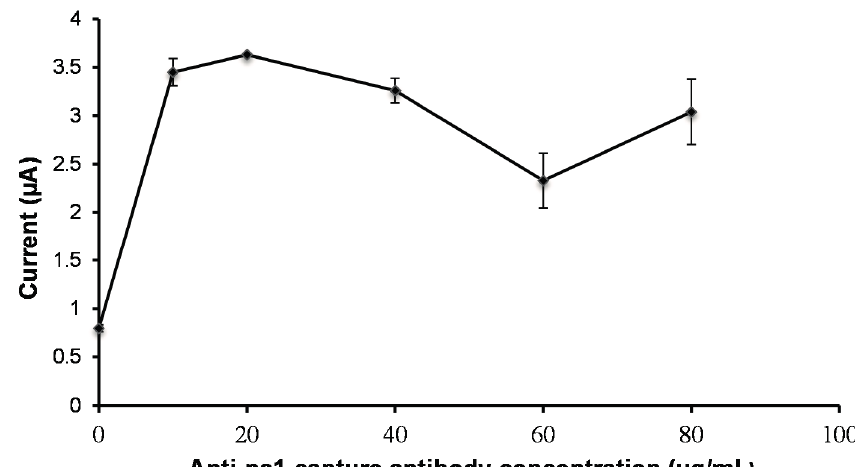
Figure 7. Optimization of the capture antibody